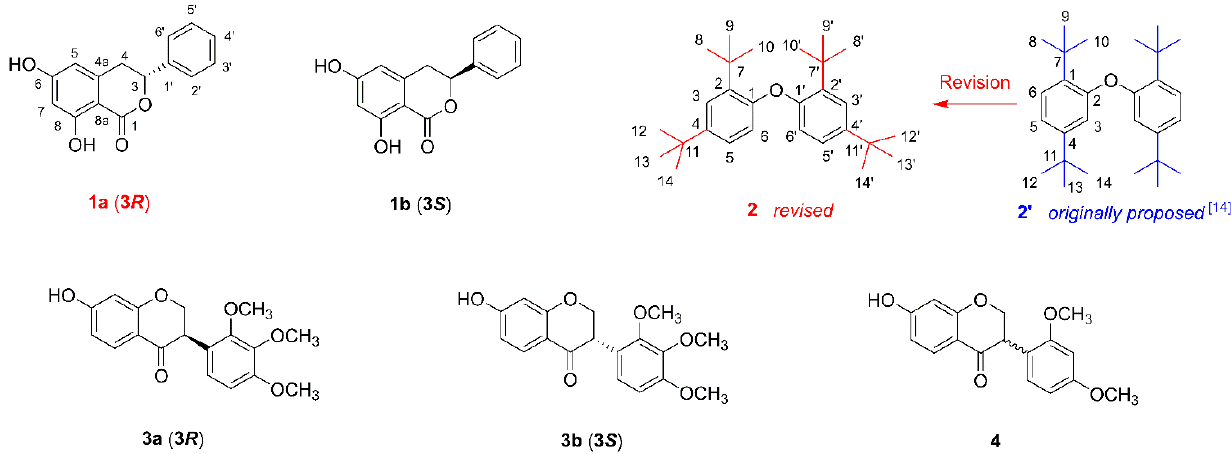
Figure 1. Chemical structures of compounds 1 – 4 isolated from rhizomes of Dioscorea collettii .